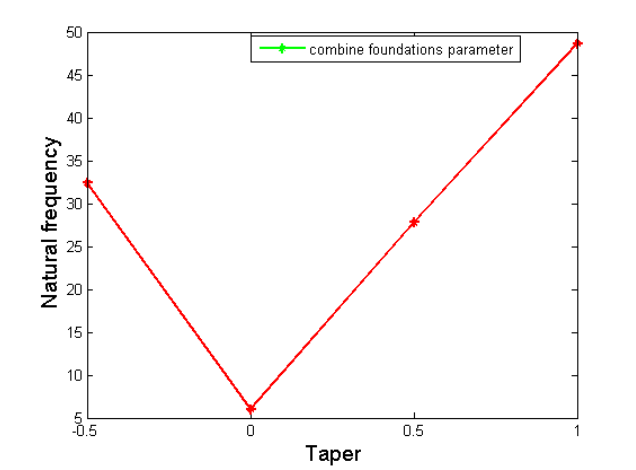
Figure 8. Influence of taper variation on combine elastic foundations on natural frequency clamped edge condition